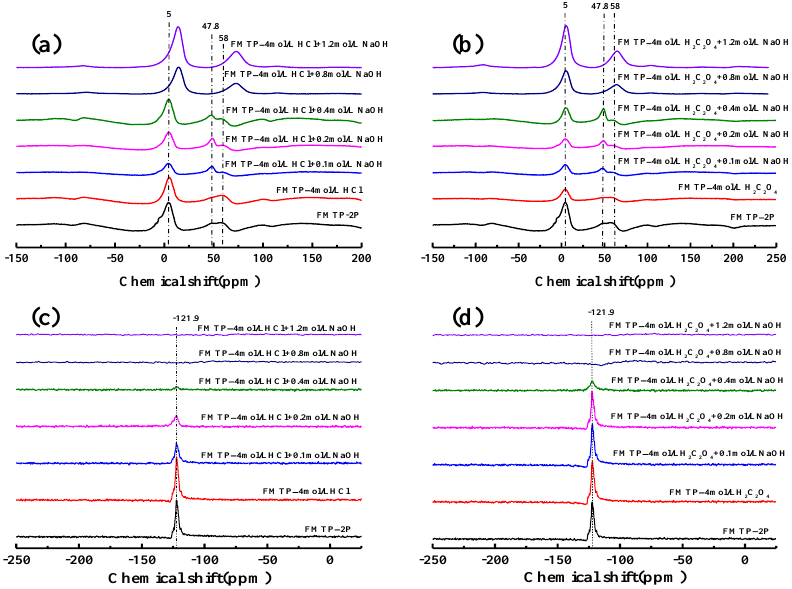
Figure 4. 27 Al MAS NMR spectra of waste catalyst samples after ( a ) 4 mol/L HCl treatment and alkali combined treatment; ( b ) 4 mol/L H 2 C 2 O 4 treatment and after alkali combined treatment. 29 Si MAS-NMR spectra of waste catalyst samples after ( c ) 4 mol/L HCl and alkali combined treatment; ( d ) 4 mol/L H 2 C 2 O 4 treatment and alkali combined treatment.